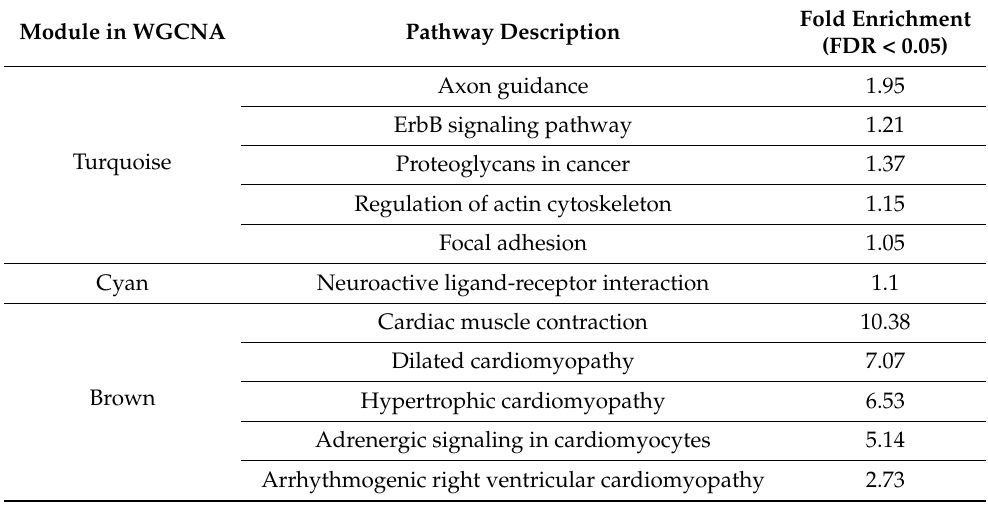
Table 1. Significant pathways in early chronicity.